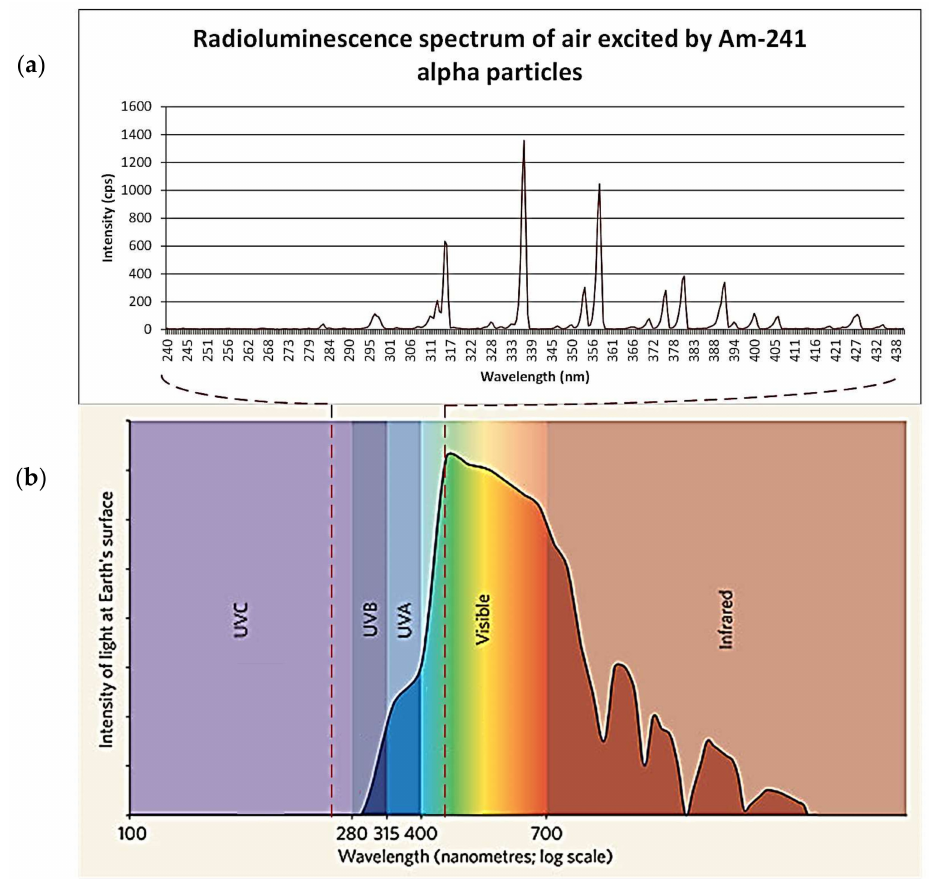
Figure 4. ( a ) Scheme of energy states of the 2P and 1N electronic-vibration band system of N 2 and N + ( b ) Nitrogen radioluminescence spectrum between 300 nm and 400 nm in dry air. The same colours are used in ( a , b ) for the corresponding spectral bands. Reprinted from [13] with permission from Elsevier.